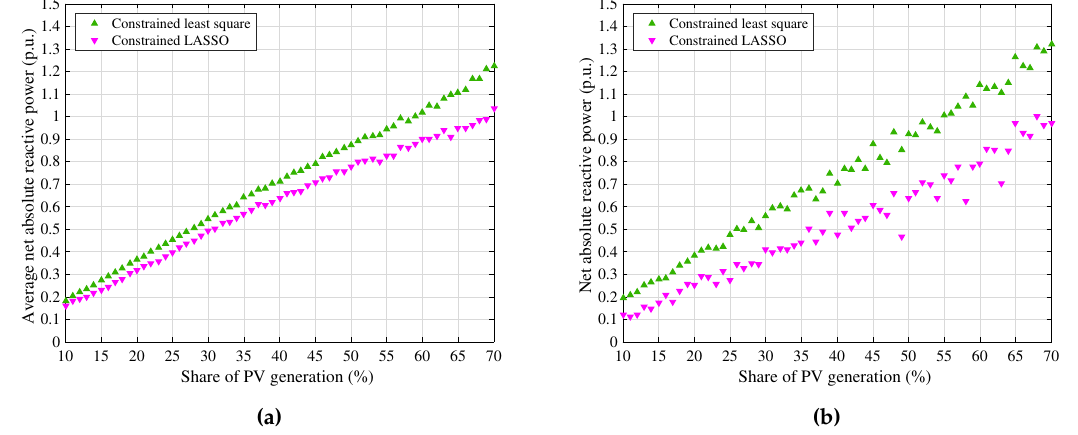
Figure 6. Net absolute reactive power generation from PV inverters with the constrained least-square method and the constrained LASSO method in the 57-bus power system. ( a ) In case of uniform distribution of PV generators; ( b ) In case of on-demand distribution of PV